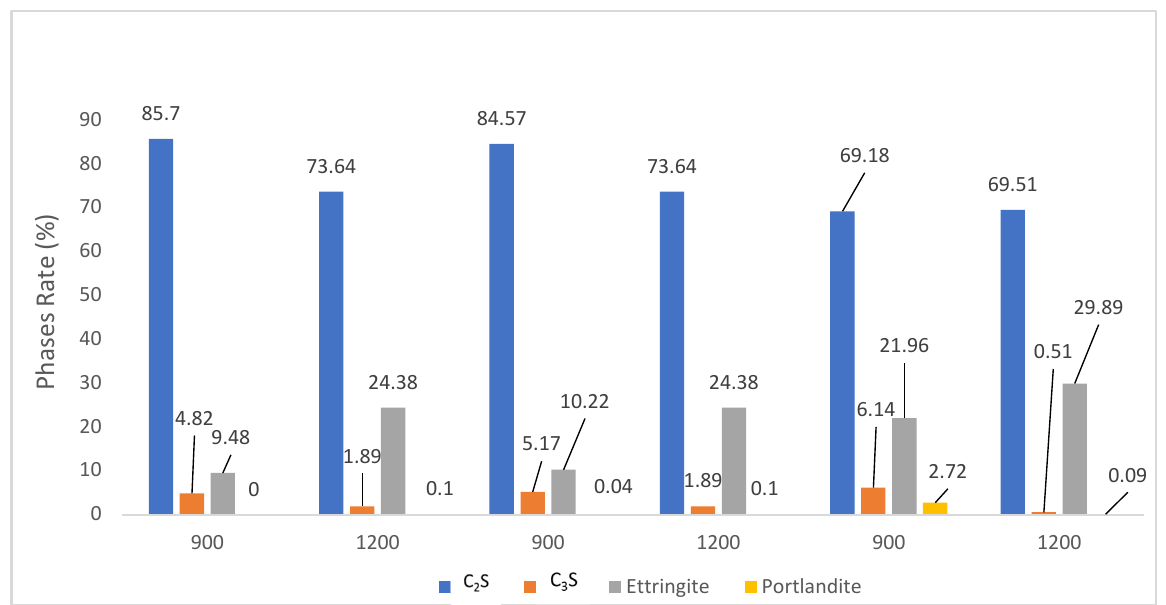
Figure 8. Phases quantifications of the anhydre cement produced by indirect mechanosynthesis.